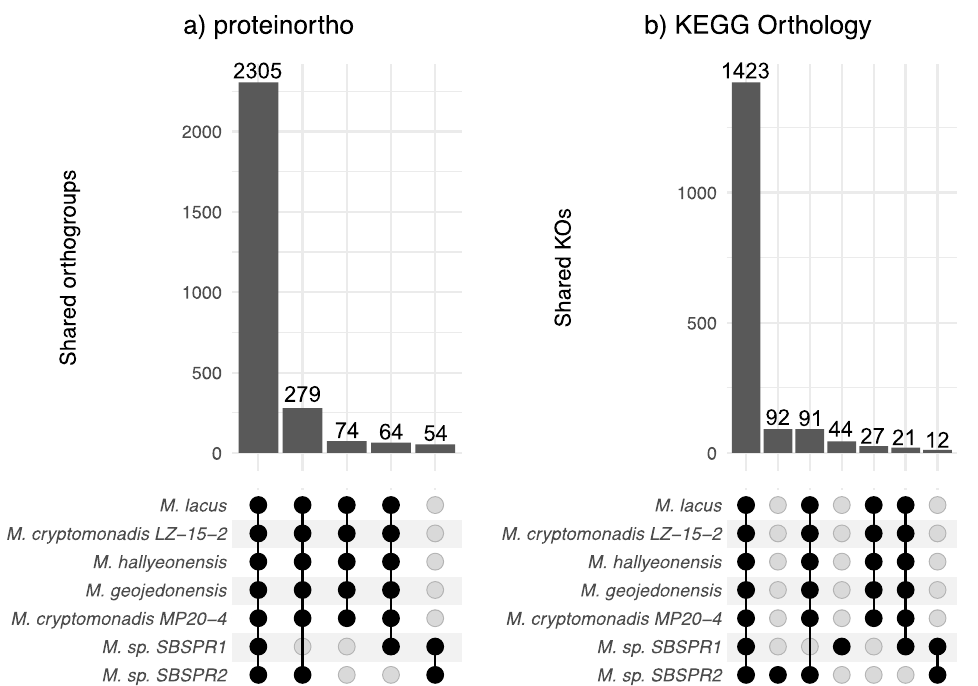
Figure 2. Shared orthologous gene groups in the genus Marivita . Intersections were calculated with ( a ) proteinortho and ( b ) KEGG orthology profiles. Displayed are intersections among all seven genomes, six other genomes but not Marivita sp. SBSPR1, six other genomes but not Marivita sp. SBSPR2, genes unique to both M . sp. SBSPR1 and SBSPR2, or genes present in only M . sp. SBSPR1 or M . sp. SBSPR2 (only applicable for shared KOs).